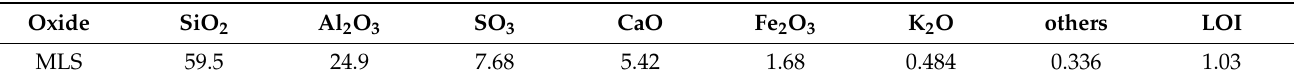
Table 1. Chemical compositions of MLS (wt%).